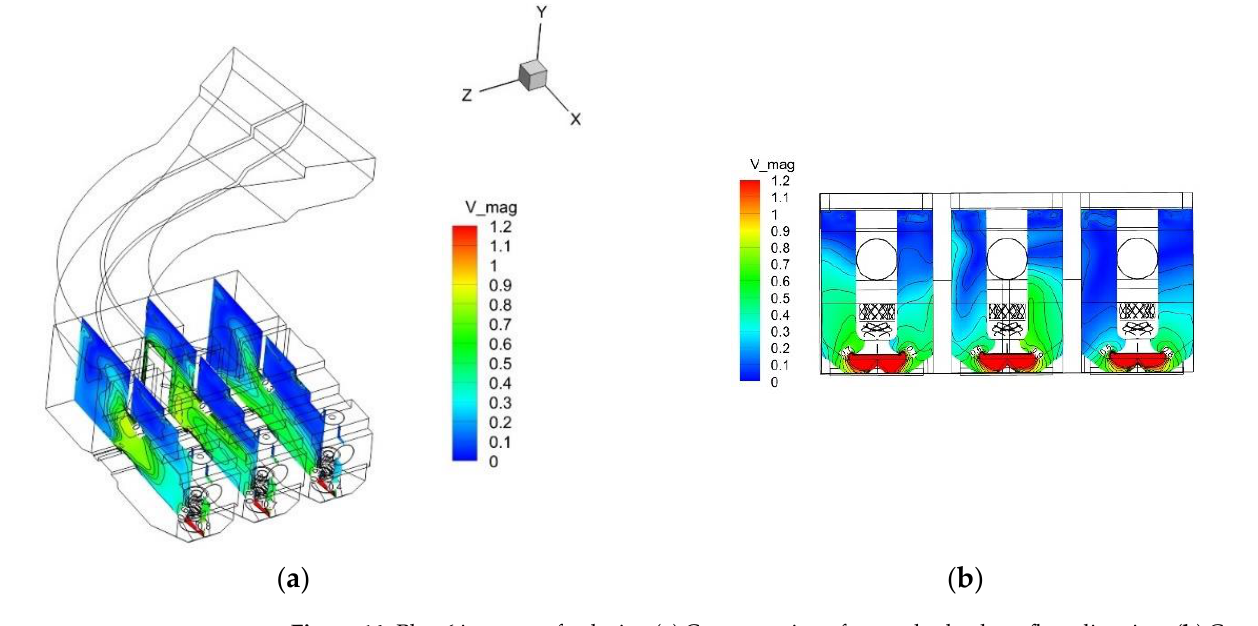
Figure 14. Plan 6 isogram of velocity. ( a ) Center section of pump body along flow direction. ( b ) Center section of pump body in vertical flow direction.